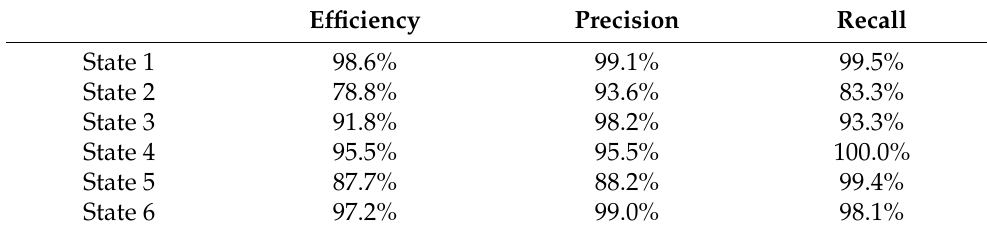
Table 5. Parameters of NET2_STATE neural network’s effectiveness in each data